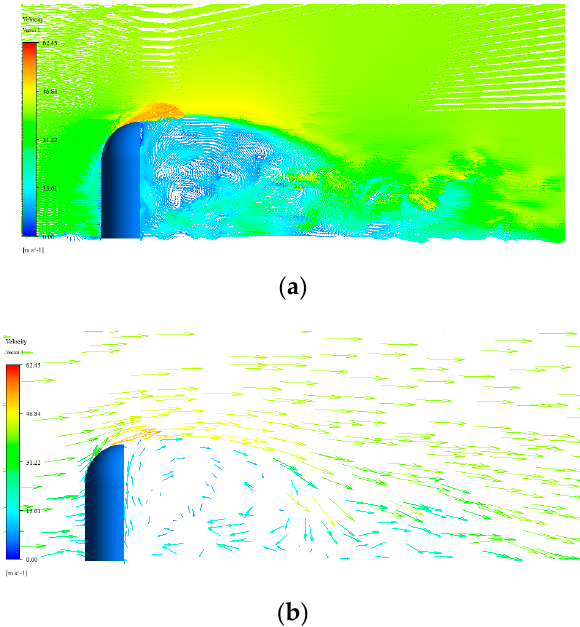
Figure 5. ( a ) Velocity vector map of the side mirror. ( b ) Local magnification of the side mirror velocity vector map.